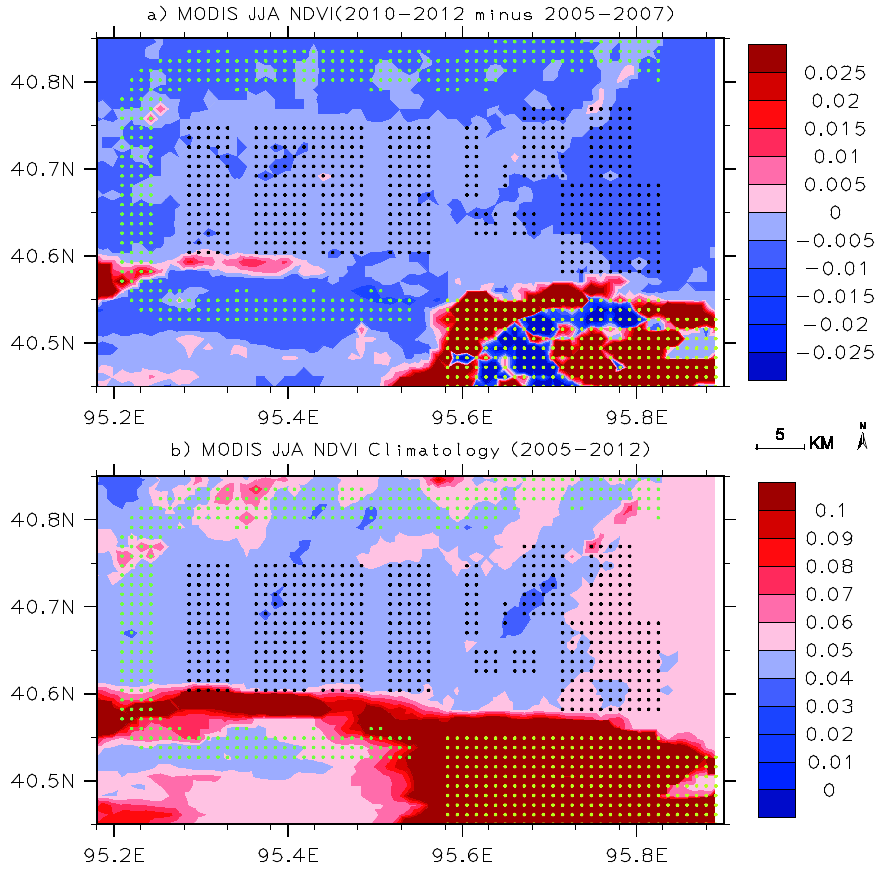
Figure 8. MODIS NDVI in JJA ( a ) differences (2010–2012 minus 2005–2007) and ( b ) the